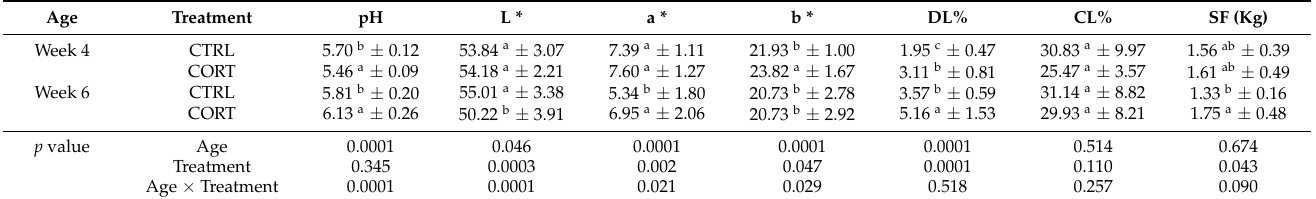
Table 8. Effect of corticosterone administration and age on physical components of CORT chicken meat ( ± SD) versus control.